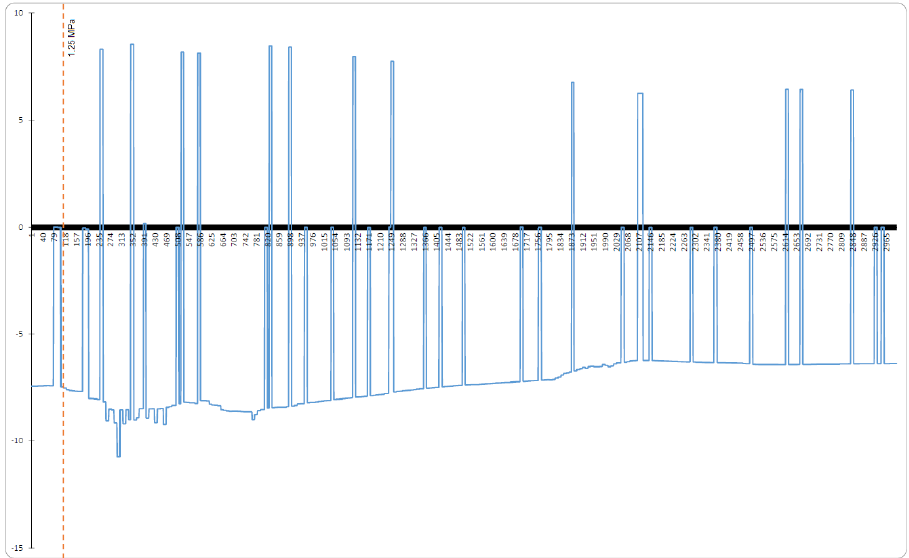
Figure 17. Characteristic of the output signal at a stress in the soil of 1.0–1.5 MPa. The potential jump with the total stress in the soil σ = 1.25 MPa and the incremented stress Δ σ = 0.25 MPa was Δ U = 3.1088 mV.